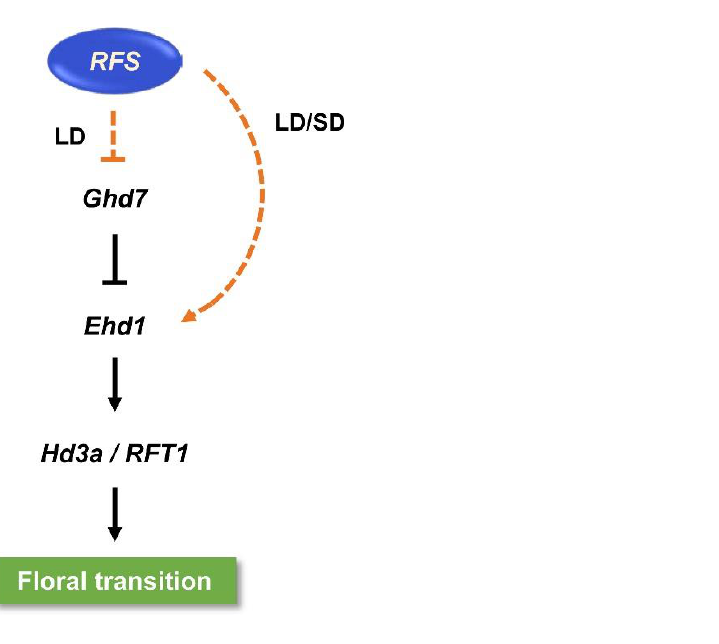
Figure 7. Proposed model of the flowering regulatory pathway controlled by RFS . RFS downregu- lates Ghd7 in LDs and upregulates Ehd1 in LD and SD conditions to induce the floral transition. Arrows represent upregulation, and lines ending with bars represent downregulation. Solid and dashed lines indicate direct and indirect regulation, respectively.